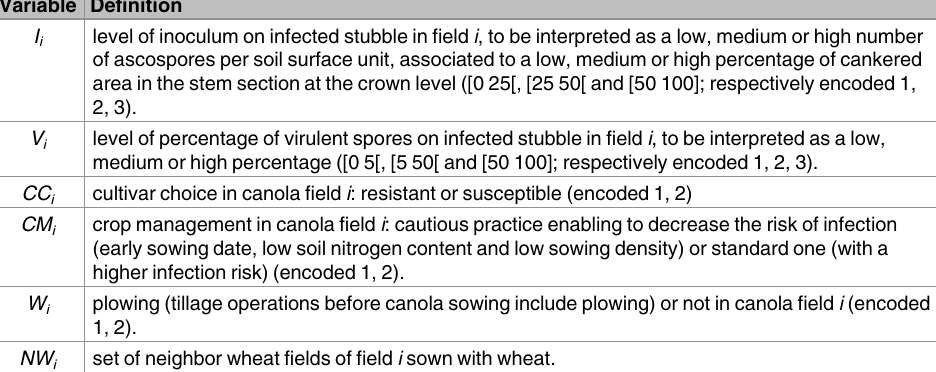
Table 3. Variables related to the GMDP model of long-term collective management of an airborne dis- ease at the landscape level. Variable